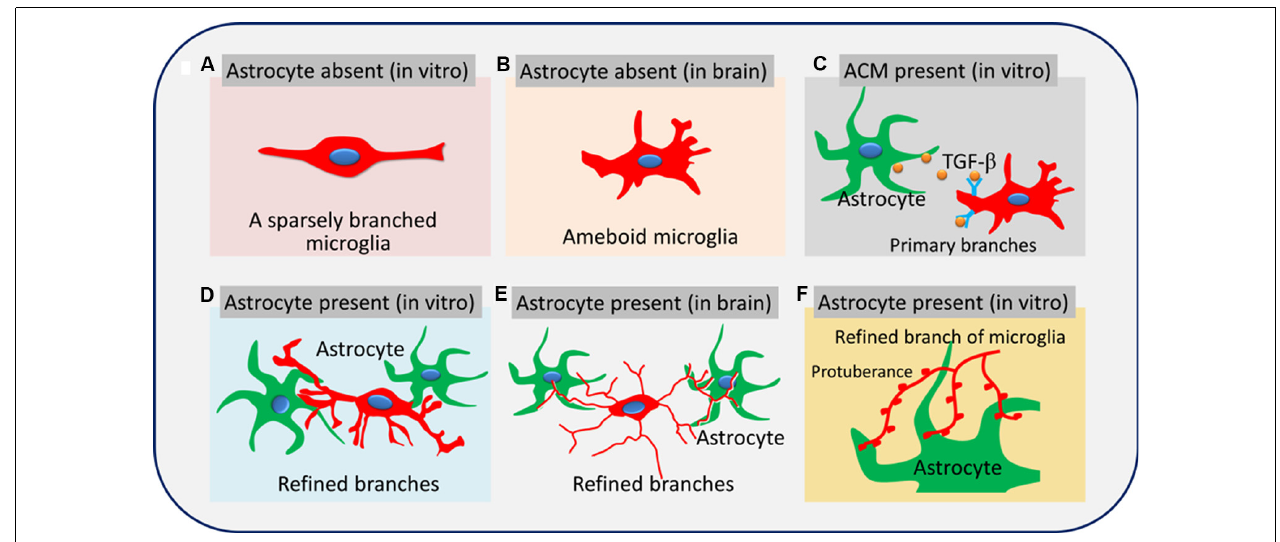
FIGURE 10 | Astrocytes promote microglial ramification by releasing TGF- β and glial fibers. Microglia are sparsely branched in brain tissue or in vitro when astrocytes are absent (A,B) . Soluble factors secreted by astrocytes, such as TGF- β , promote the formation of primary branches of microglia (C) . Glial fibers from astrocytes promote the formation of refined branches (main branches are small in diameter with sub-branches and protuberances; D–F